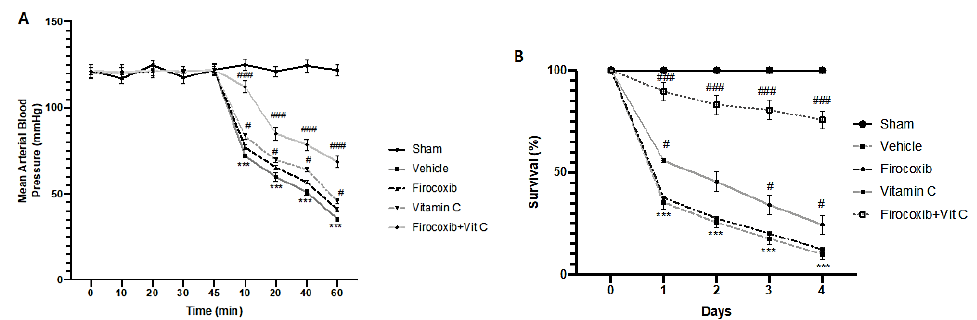
Figure 1. E ff ect of combined therapy of firocoxib and vitamin C on ischemic reperfusion (I / R)-induced mortality and arterial blood pressure: ( A ) Mean arterial blood pressure and ( B ) survival (%). n = 5 animals from each group for each analysis. A p -value of < 0.05 was considered significant; # p < 0.05 vs. vehicle, *** p < 0.001 vs. sham + vehicle, and ### p < 0.001 vs. vehicle.